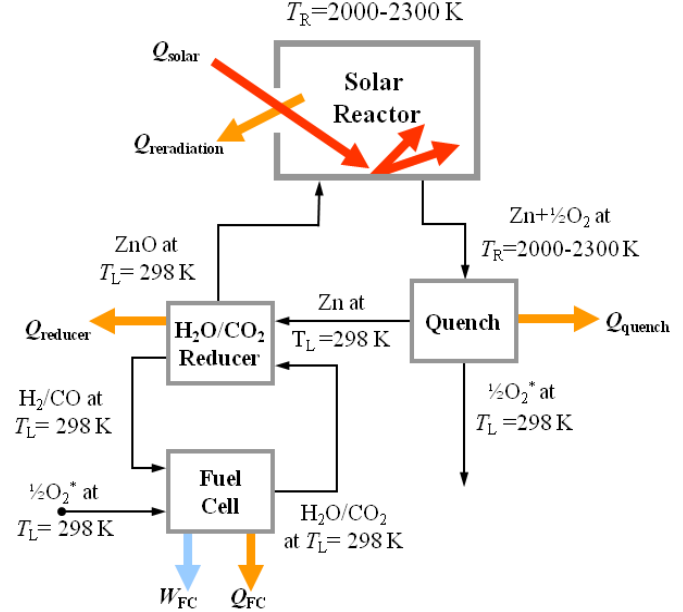
Figure 2. Model flow diagram for second-law analysis of the two-step H thermochemical cycle based on Zn/ZnO redox